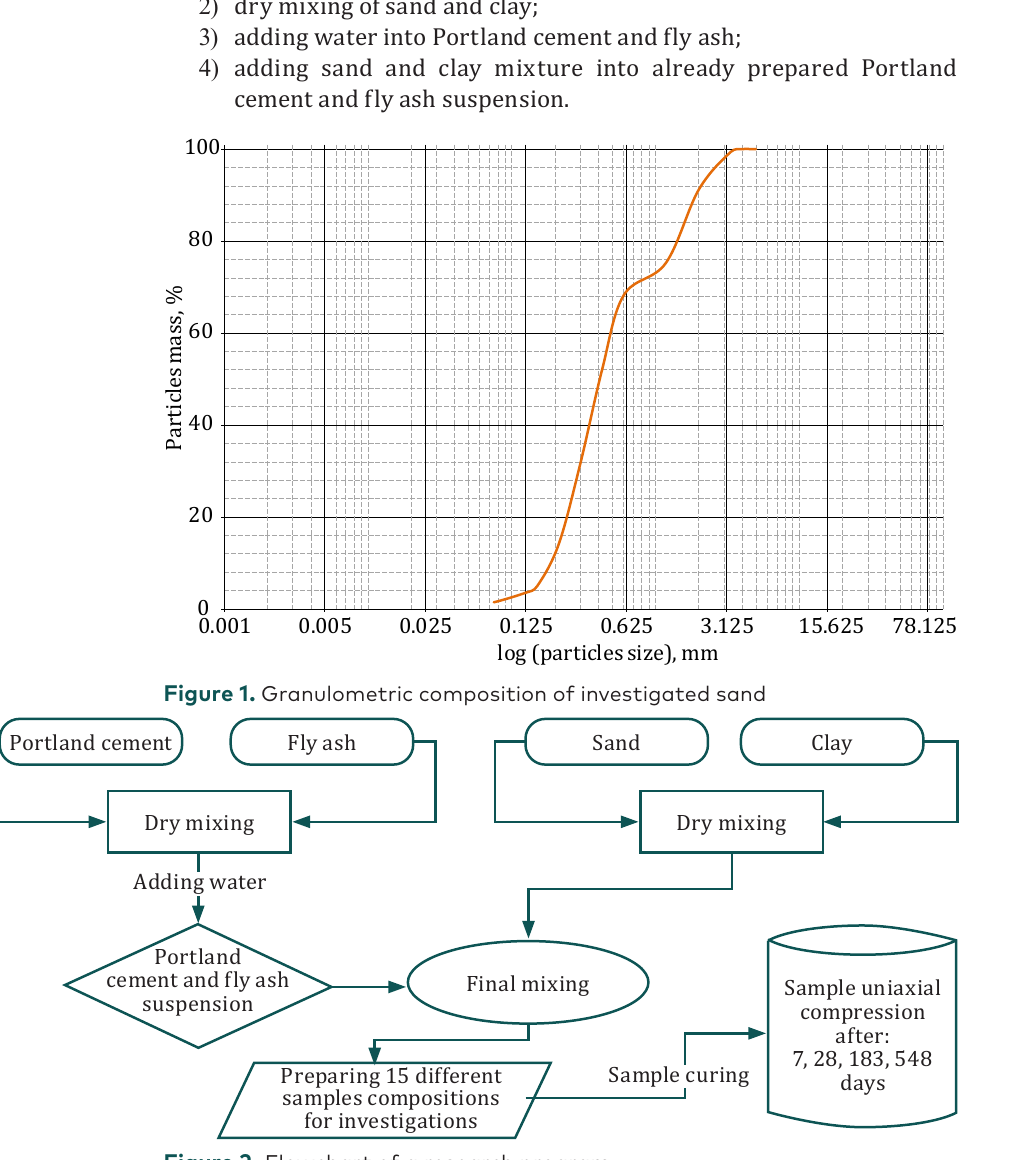
Figure 2. Flowchart of a research